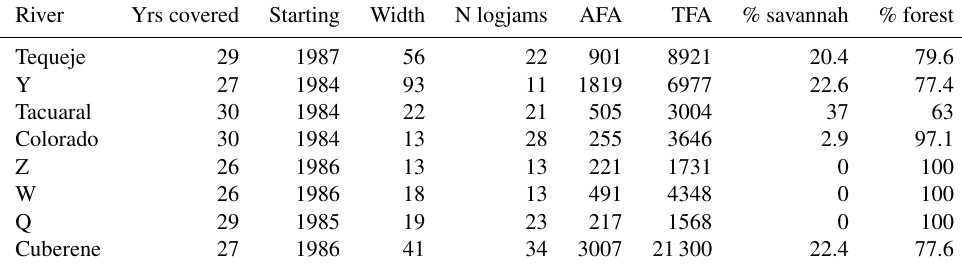
Table 1. Overview of the dynamics of the logjams and their effect on the forest. “Yrs covered” is the number of years for which cloud-free Landsat imagery was available, “starting” is the year of the oldest cloud-free Landsat image available, “width” is the width of the river in meters, “N logjams” is the number of logjams detected for each river during the period 1984–2016, and “AFA” stands for “average flooded area” and is the average number of hectares that are flooded when there is a logjam-induced flood in a given river. TFA stands for “total flooded area” and is the number of hectares that have been flooded in total during the period 1984–2016. TFA is smaller than the sum of the AFA for all the years because large extents of land are often repeatedly flooded, so there is a significant overlap between areas flooded in different years. The “% savannah” and “% forest” values indicate the type of vegetation cover in 1984 (percentage of the TFA). River Yrs covered Starting Width N logjams AFA TFA % savannah % forest